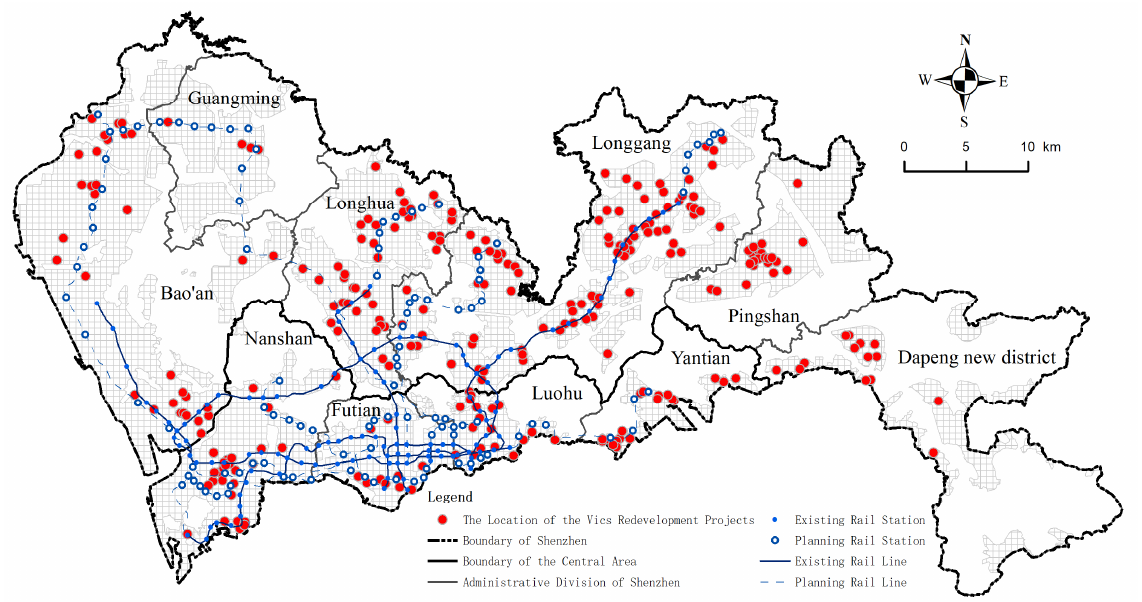
Figure 10. Distribution of urban village redevelopment along the rail transit.